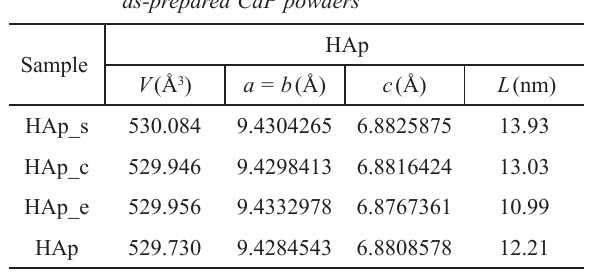
Table 2 – Unit cell parameters and crystal size of HAp in the as-prepared CaP powders